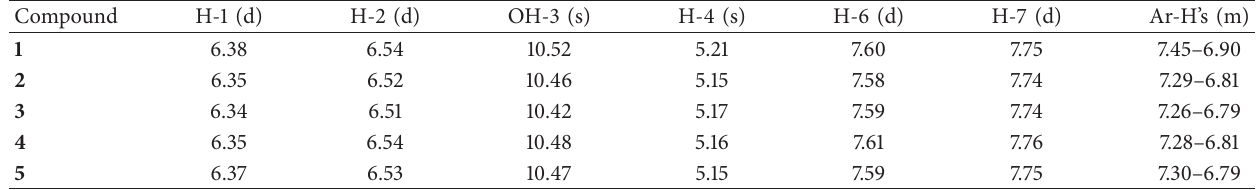
Table 3: Proton NMR chemical shift ( 𝛿 , ppm) data of curcumin analogues 1 – 5 .